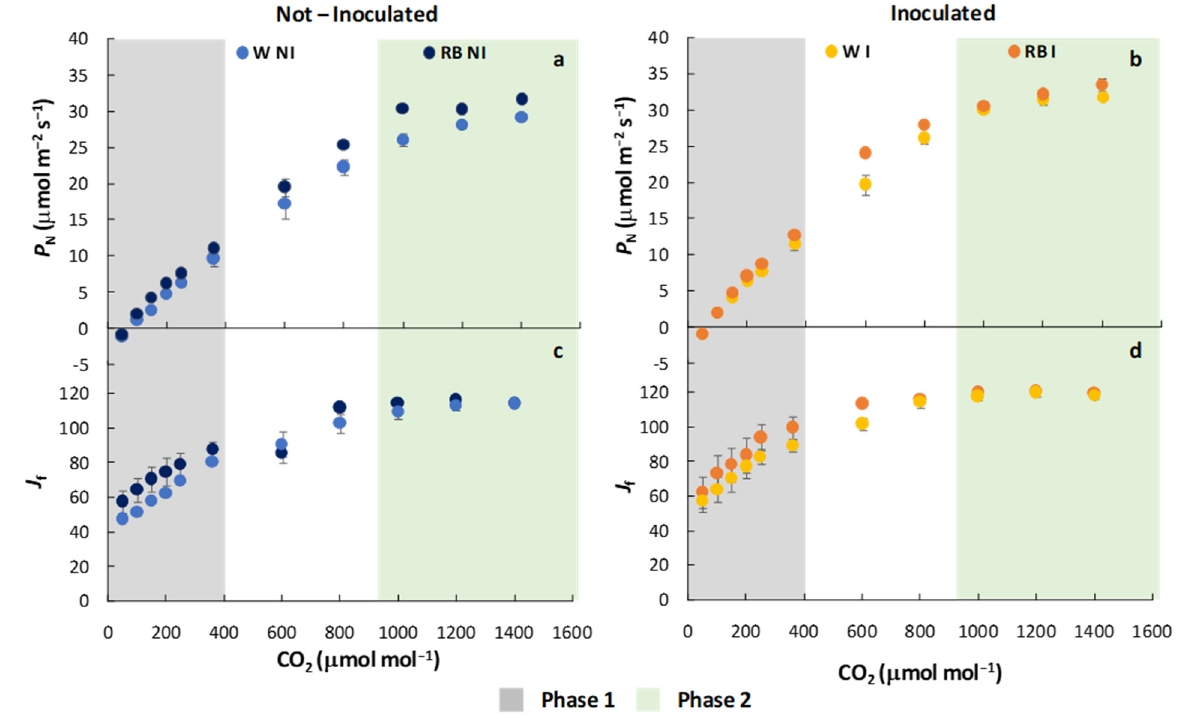
Figure 4. Net photosynthesis, P N(CRC) ( a , b ); electron transport rate, J f ( c , d ) of not-inoculated (NI) and inoculated (I) spinach plants grown under W and RB light regimes. Data are means ± standard error (n = 5). phase 1 (green) and phase 2 (grey).